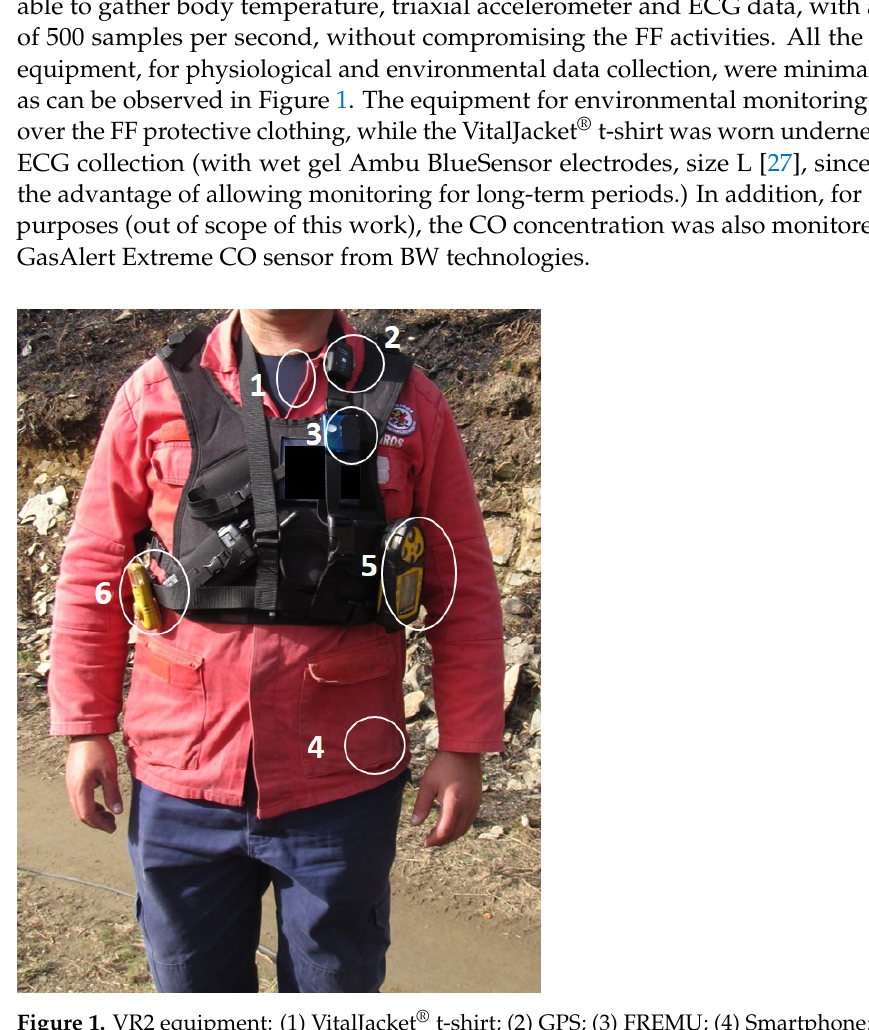
Figure 1. VR2 equipment: (1) VitalJacket ® t-shirt; (2) GPS; (3) FREMU; (4) Smartphone; (5) GasAlert Extreme CO; (6) GasAlertMicro 5